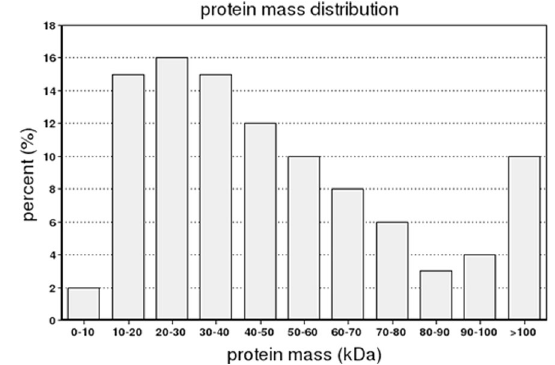
Figure 1. Protein mass distribution of Amur sturgeon